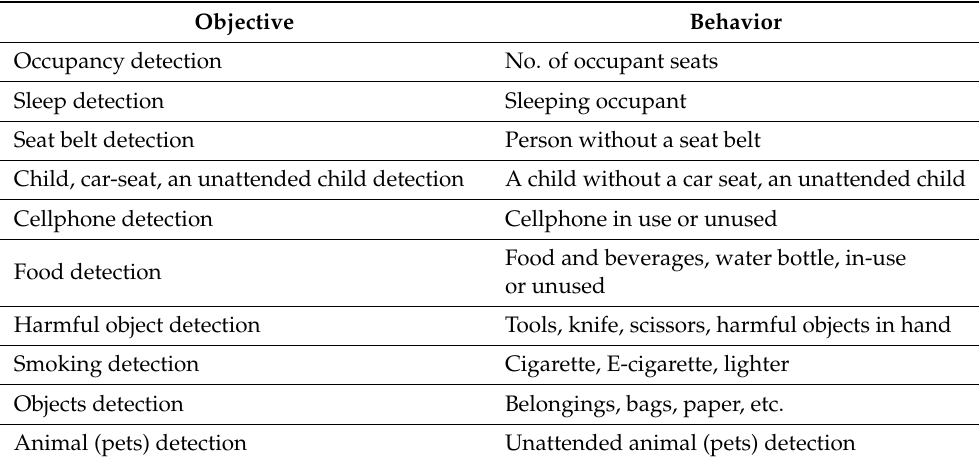
Table 2. Summary of the objectives and activities performed in our DB.